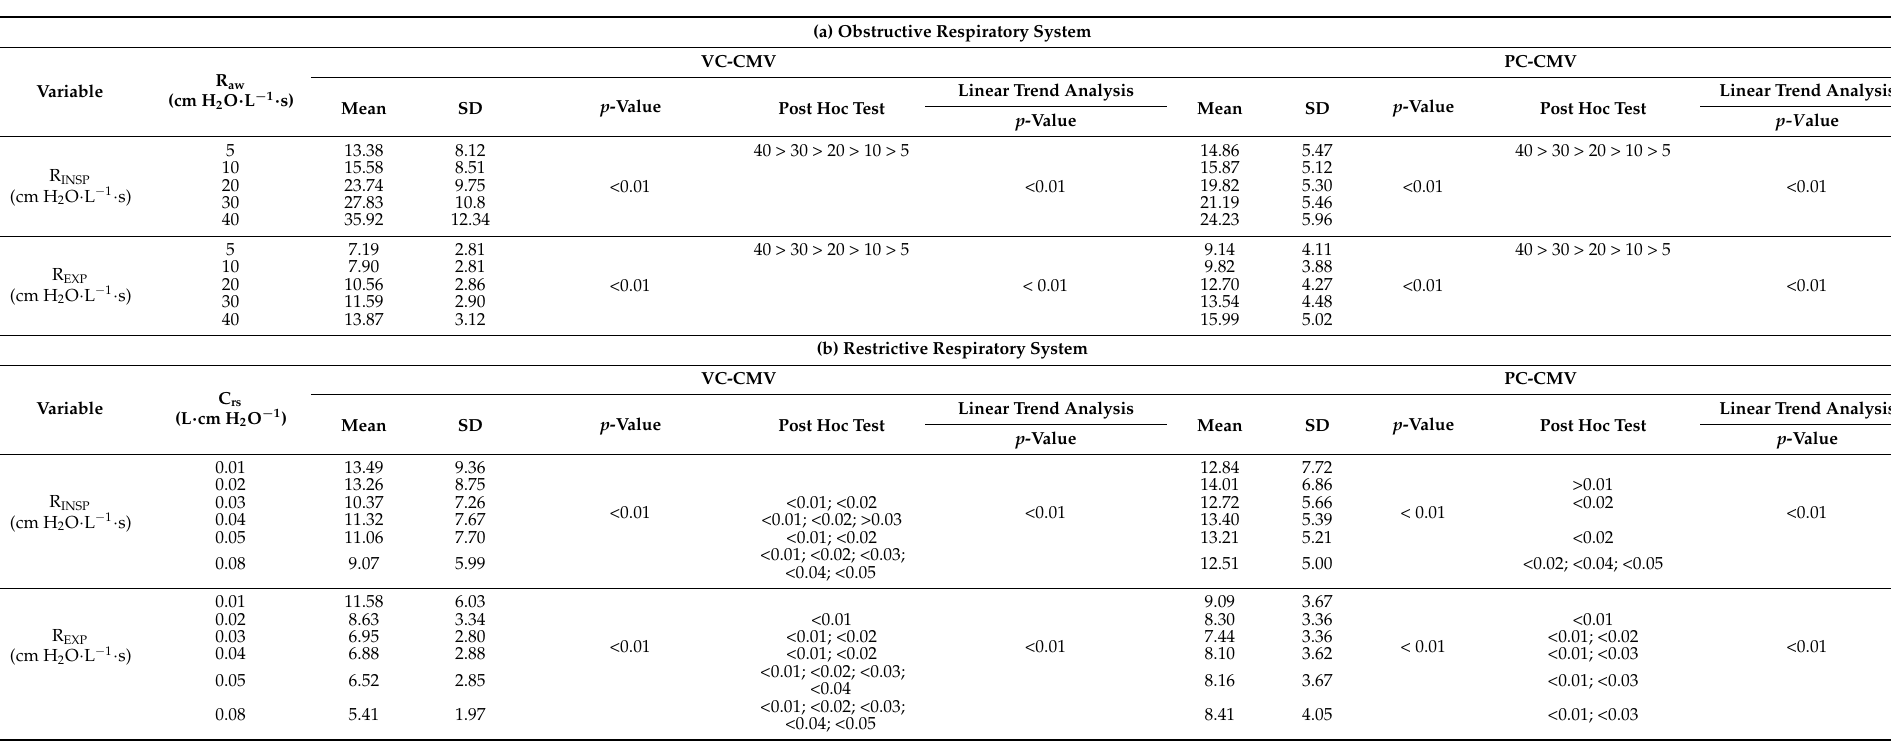
Table 1. Changes of mean respiratory resistance in the various pulmonary mechanics during the closed suctioning process: ( a ) Change in airway resistance of pulmonary mechanics for the obstructive respiratory system; ( b ) Change in the lung compliance of pulmonary mechanics for the restrictive respiratory system during two ventilation modes (VC-CMV or PC-CMV). (a) Obstructive Respiratory System Variable